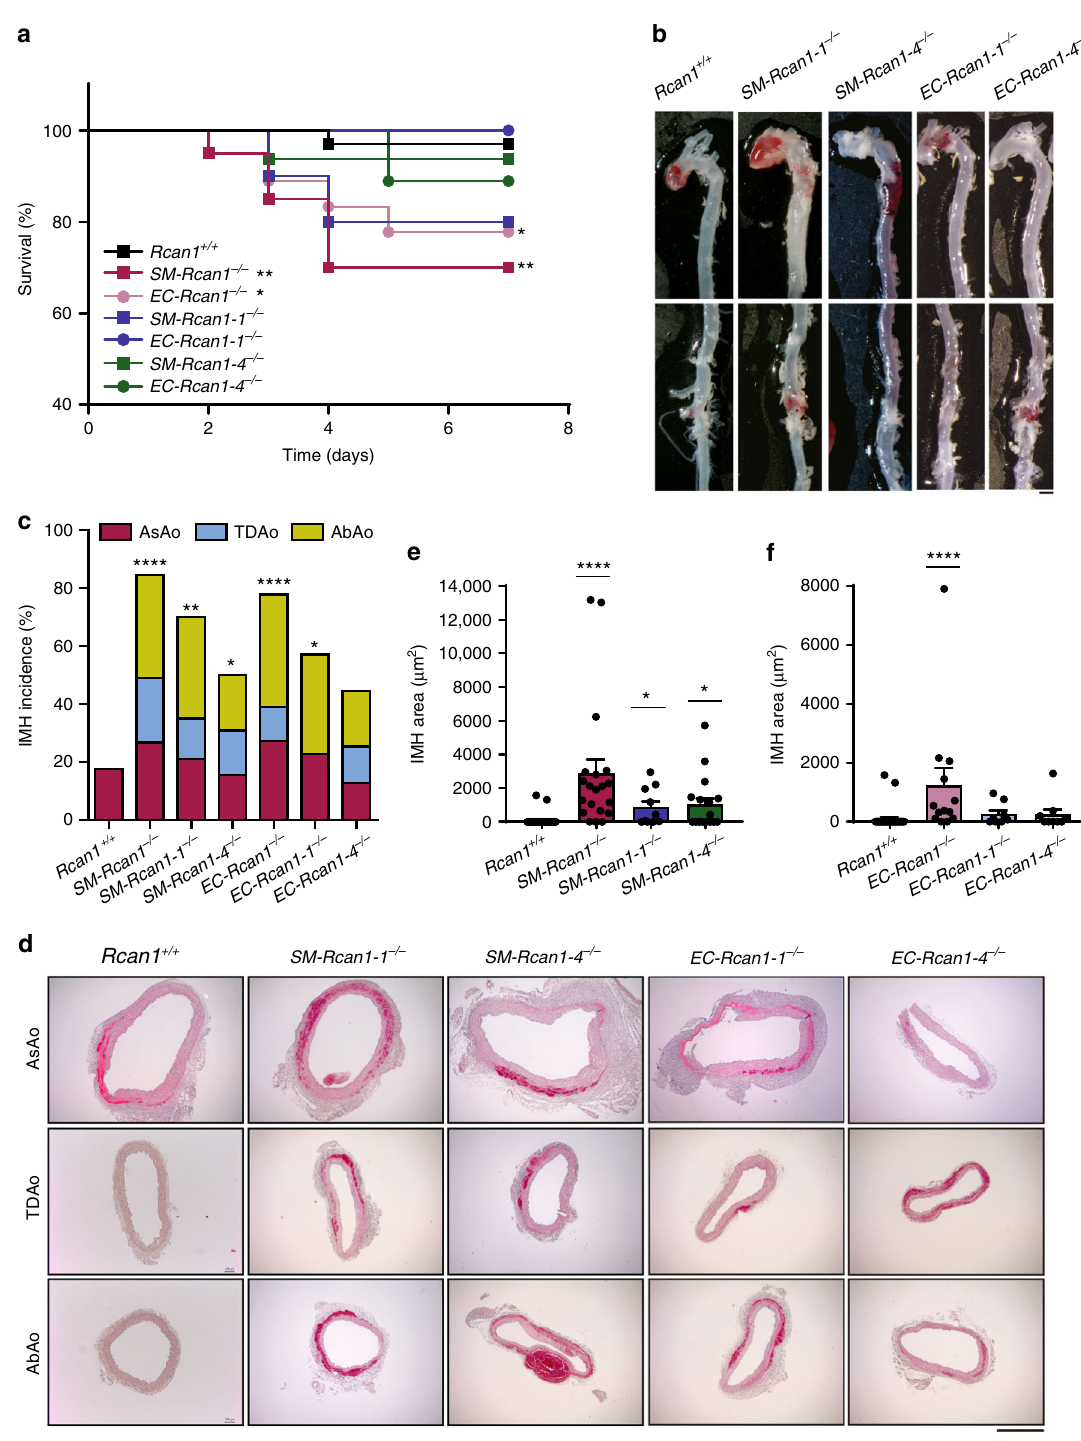
Fig. 2 Rcan1-1 and Rcan1- 4 contribute to aortic homeostasis. Six-eight-week-old SM-Rcan1-1 − / − ( n = 10), SM-Rcan1-4 − / − ( n = 16), EC-Rcan1-1 − / − ( n = 7), and EC-Rcan1-4 − / − ( n = 9) male mice were treated with AngII at the same time as the SM-Rcan1 − / − ( n = 20), EC-Rcan1 − / − ( n = 18), and control Rcan1 + / + ( n = 39) mice described in Fig. 1. Quantitative data for SM-Rcan1 − / − , EC-Rcan1 − / − , and control Rcan1 + / + are therefore the same in both fi gures. a Survival curves. Log-rank (Mantel-Cox) test, ** p < 0.01, * p < 0.05 vs. Rcan1 + / + . All deaths were due to aortic rupture. b Representative images of macroscopic hematomas in aortas from mice euthanized at the end of the experiment. Scale bar, 1 mm. c IMH incidence in the AsAo, TDAo, and AbAo of the same mice. Chi-square distribution, **** p < 0.0001, ** p < 0.01, * p < 0.05 vs. Rcan1 + / + . d Representative images of hematoxylin-eosin staining of aortic sections from the indicated genotypes and IMH area quanti fi cation in aortic sections from e SM-Rcan1 − / − , SM-Rcan1-1 − / − , and SM-Rcan1-4 − / − mice and f from EC- Rcan1 − / − , EC-Rcan1-1 − / − , EC-Rcan1-4 − / − , and control Rcan1 + / + mice. Each data point denotes an individual mouse, whereas histograms denote means ±